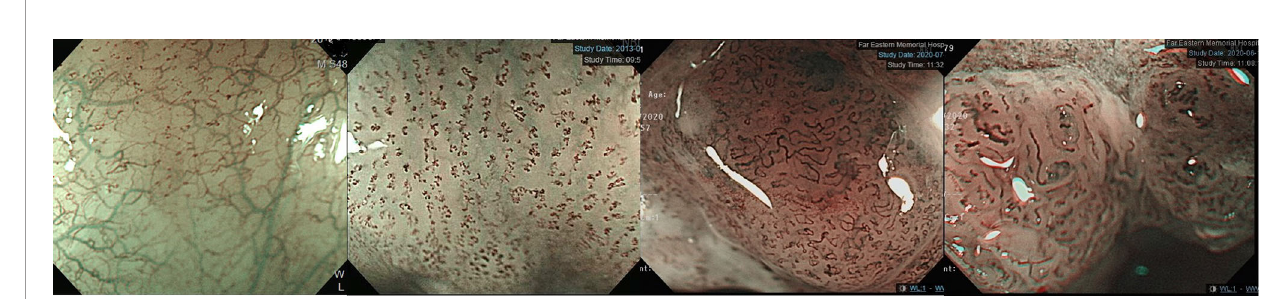
FIGURE 6 | JES classi fi cation of microvessel morphology of IPCL. From left to right : JES type A- Normal IPCL without irregularity. JES type B1- Abnormal microvessels with severe irregularity, meandering caliber or highly dilated proliferative abnormal vessels with a loop-like formation. JES type B2- Abnormal microvessels with severe irregularity, meandering calibers or highly dilated proliferative abnormal vessels without a loop-like formation. JES type B3- Highly dilated microvessels with three times as many calibers than usual type B2 vessels. IPCL, intraepithelial papillary capillary loop; JES, Japanese Esophageal Society.